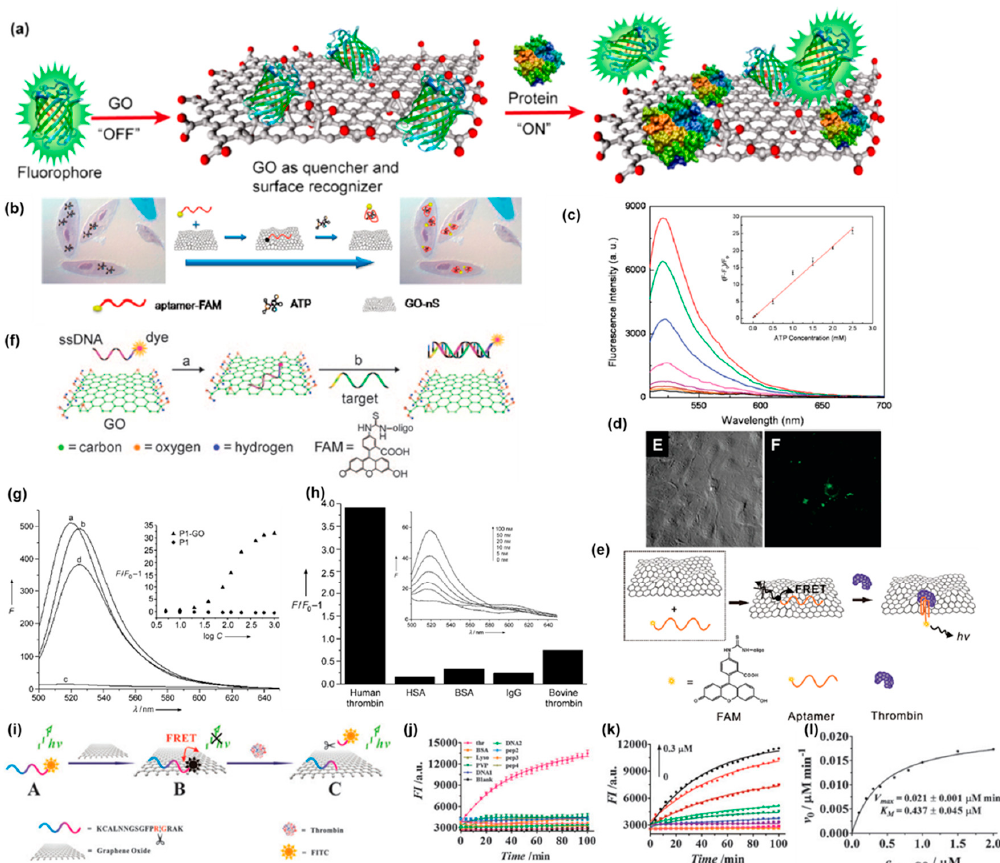
Figure 1. ( a ) Motif and fabrication of the (Graphene oxide) GO nS-based sensor assay. GO